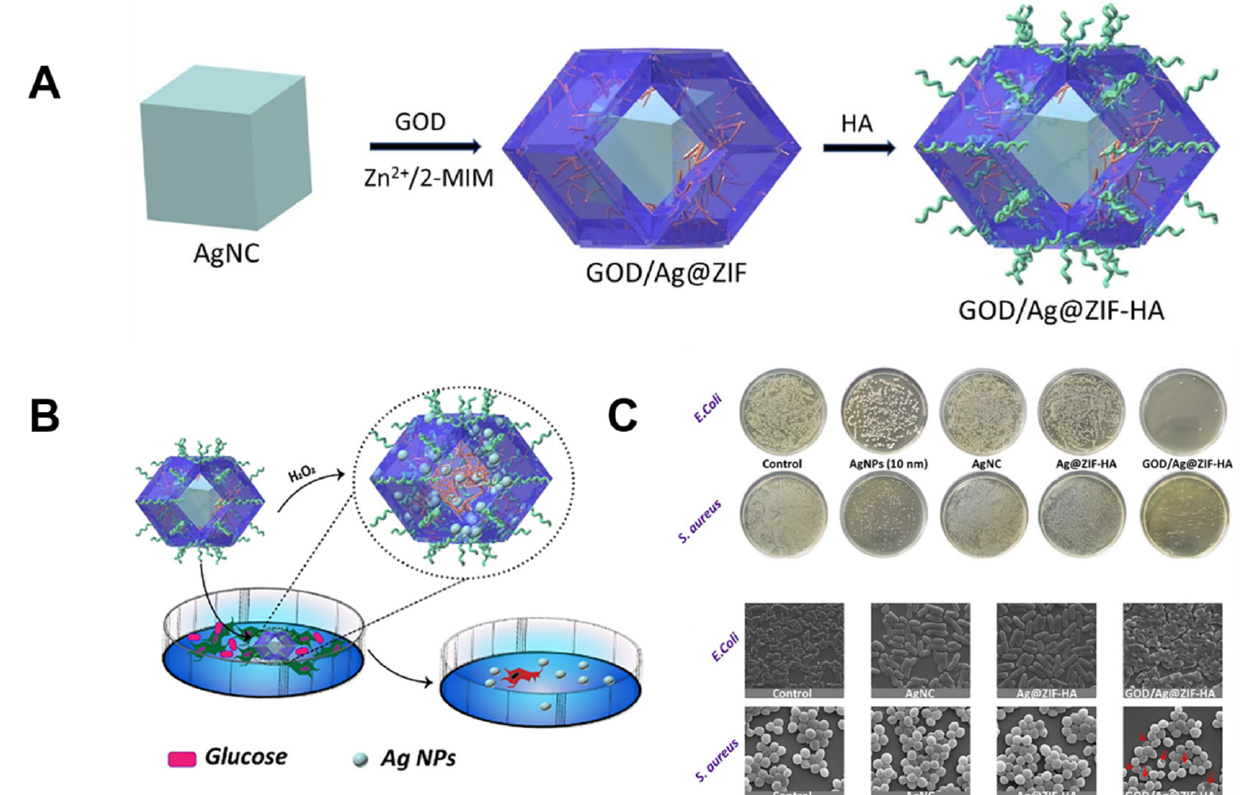
Figure 6. ( A ): Schematic illustration of the preparation of the GOD/Ag @ZIF-HA nanocomposites. ( B ): Schematic illustration of the antibacterial application of GOD/Ag @ZIF-HA. ( C ): Photographs of E. coli and S. aureus bacteria treated with different nanocomposites at the same Ag concentration (2-fold MIC value and SEM image E. coli and S. aureus bacteria strains treated with different nanocomposites. Reproduced with permission from [133].